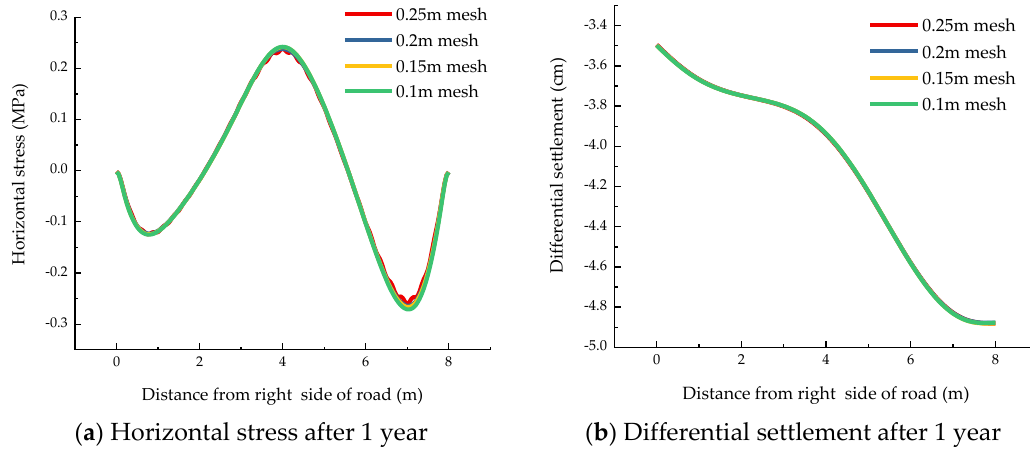
Figure 7. Mesh sensitivity analysis.